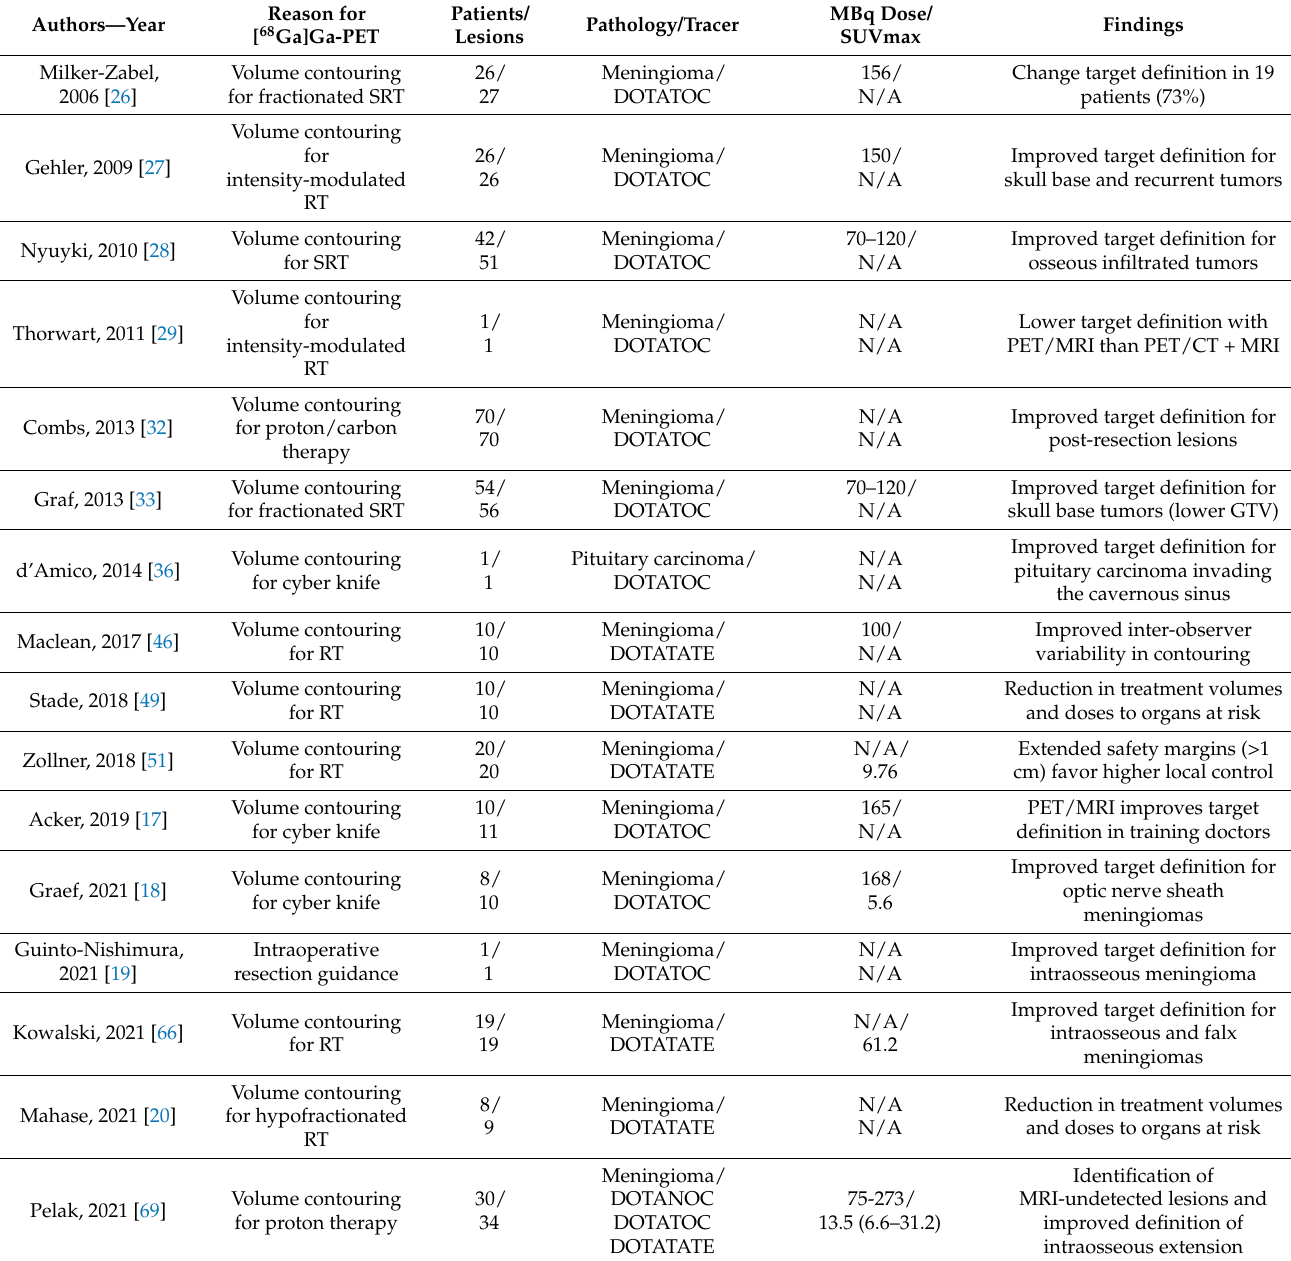
Table 3. Overview of all included studies using 68 Ga-DOTA-SSTR PET for planning radiotherapy and/or surgical